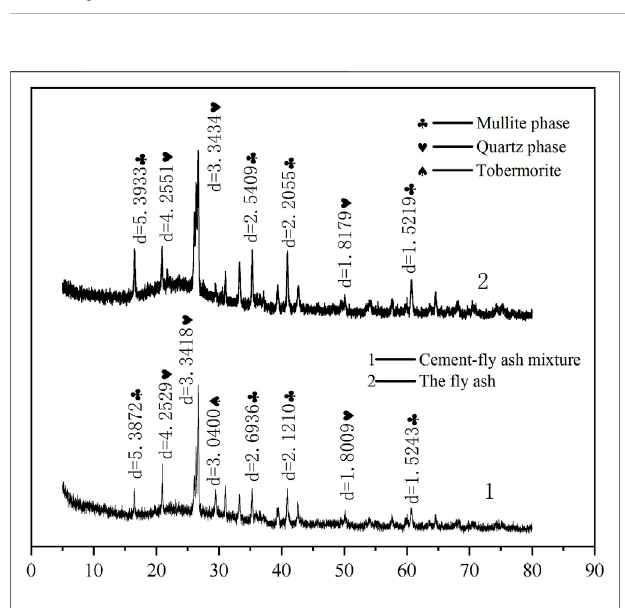
FIGURE 2 | Fly ash diffraction